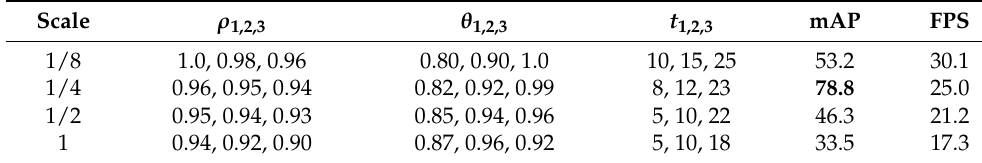
Table 1. Comparison between the different scales of the line mask in terms of mAP and speed on